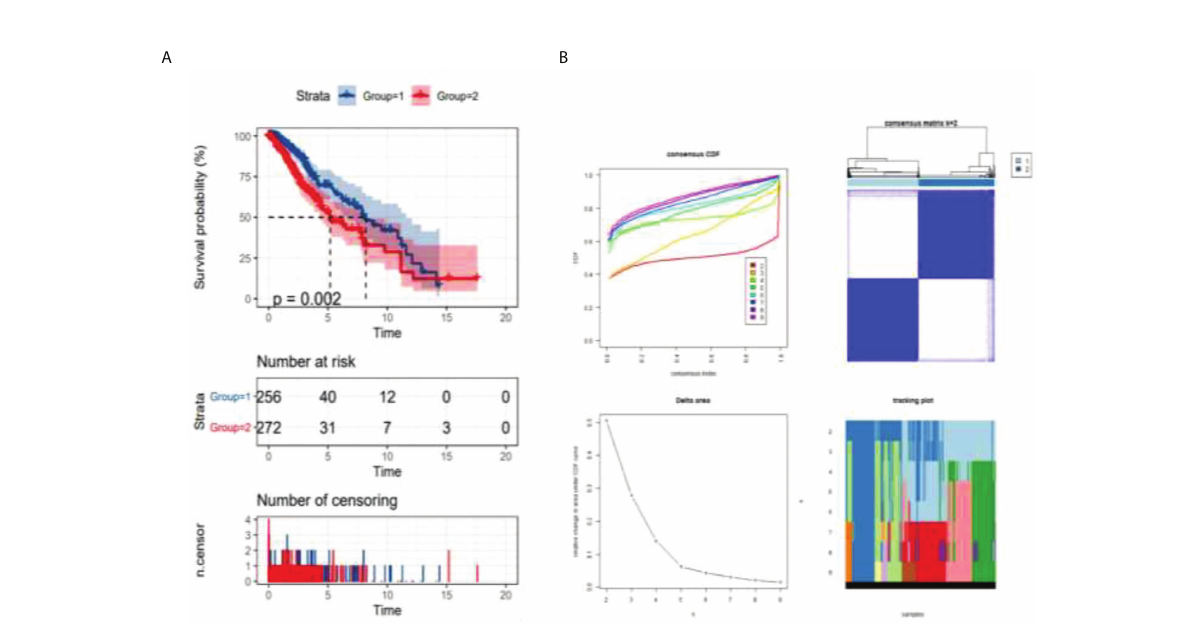
FIGURE 2 Analysis of survival probability of LGG patients. p = 0.002 < 0.05 (logrank test) (A) survival analysis of different groups, (B) consensus analysis de fi ned two possible groups.